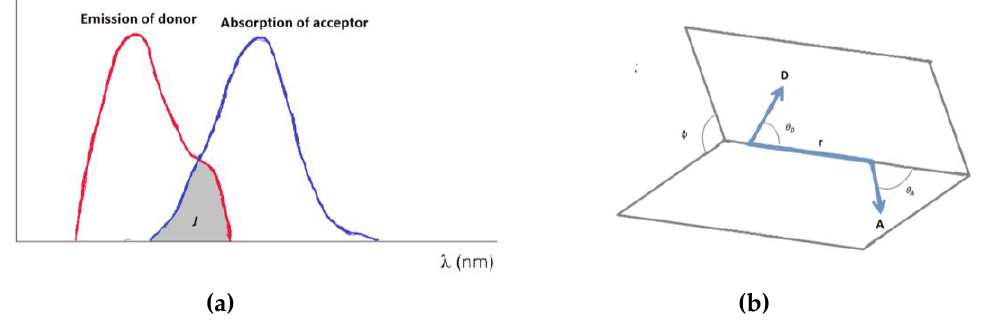
Figure 1. Main parameters of FRET: ( a ) Spectral overlap, J, of donor emission and acceptor absorption (necessary for FRET); ( b ) Transition dipole orientation of the donor D and the acceptor A.